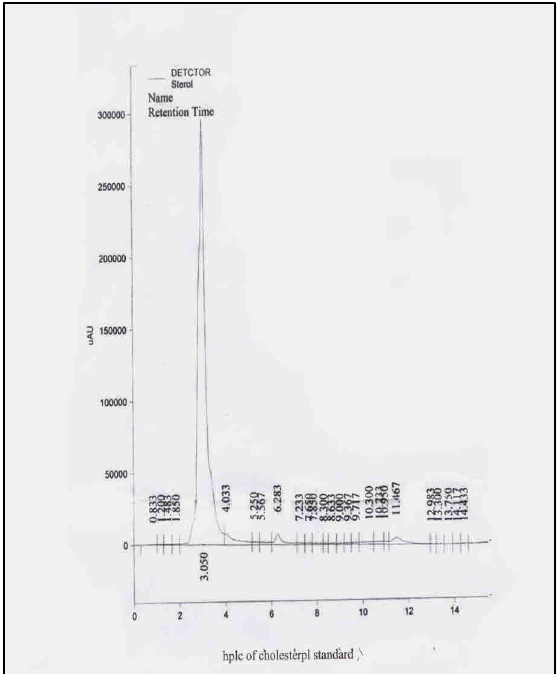
Figure (9) :HPLC chart of